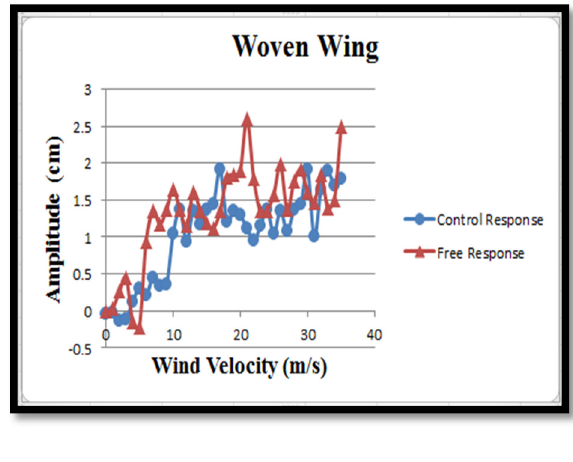
Fig. 9. Relation between wind velocity and Controlling Amplitude.